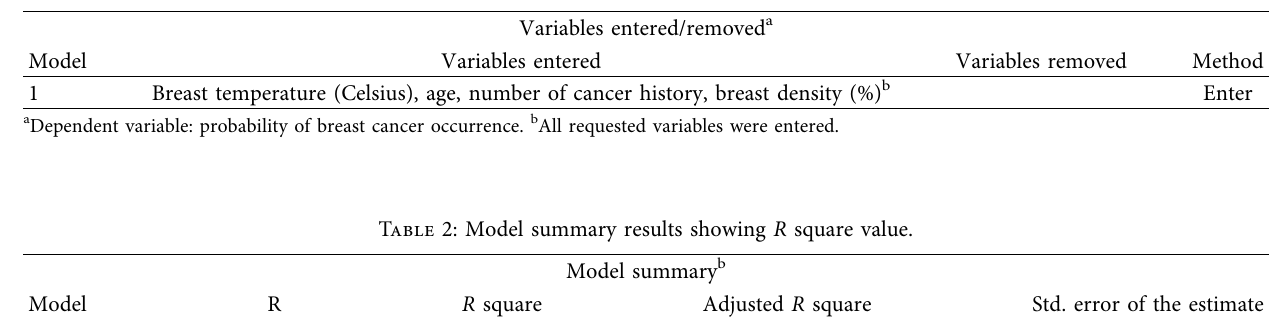
Figure 6: Flowchart of the research. Table 1: Independent and dependent variables.